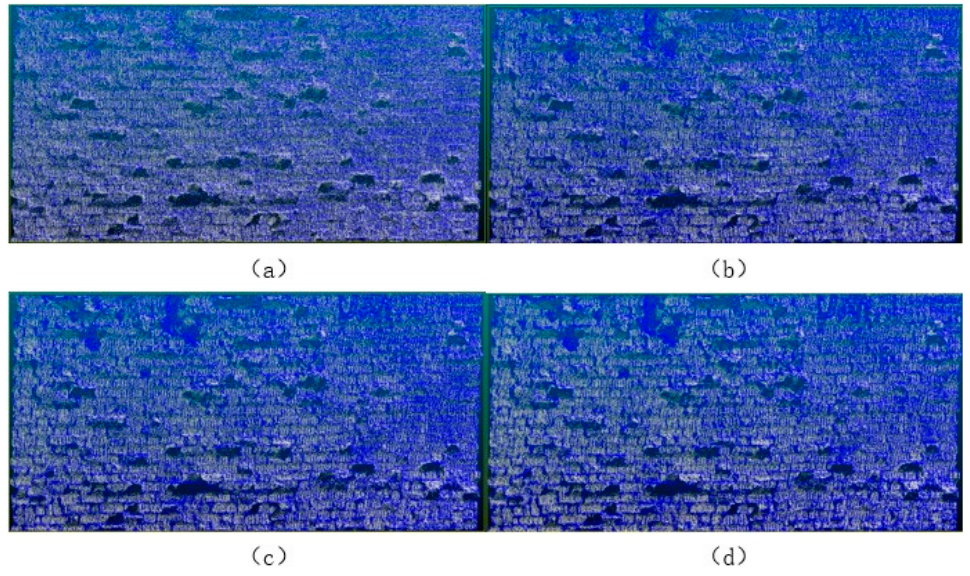
Figure 23. Point cloud marked by Structure Tensor Linearity. ( a ) K = 4. ( b ) K = 6. ( c ) K = 8. ( d ) K = 10. Table 3. Feature calculation speed, differentiation between bricks, and defect identification ability under different values of K